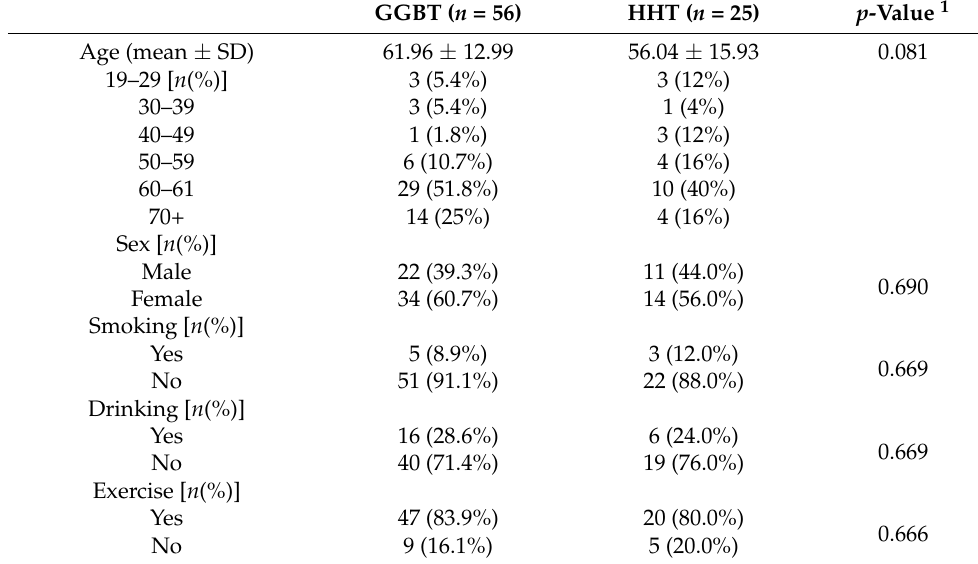
Table 1. Baseline characteristics for